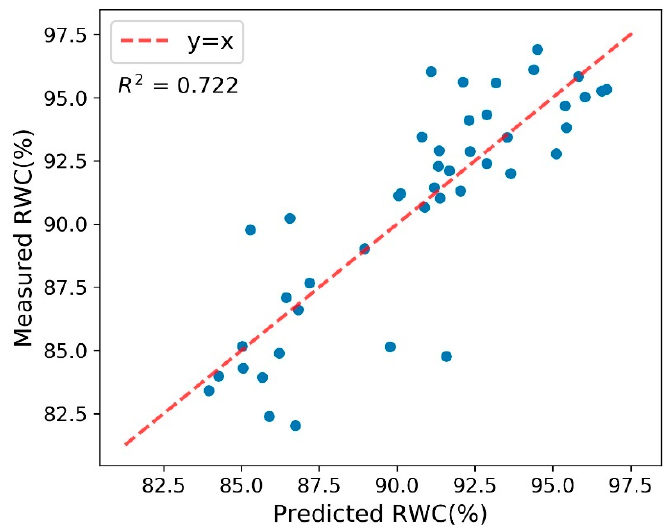
Figure 4. The Relative Water Content (RWC) prediction model based on Partial Least Square Regression Relative (PLSR): measurement vs. prediction.